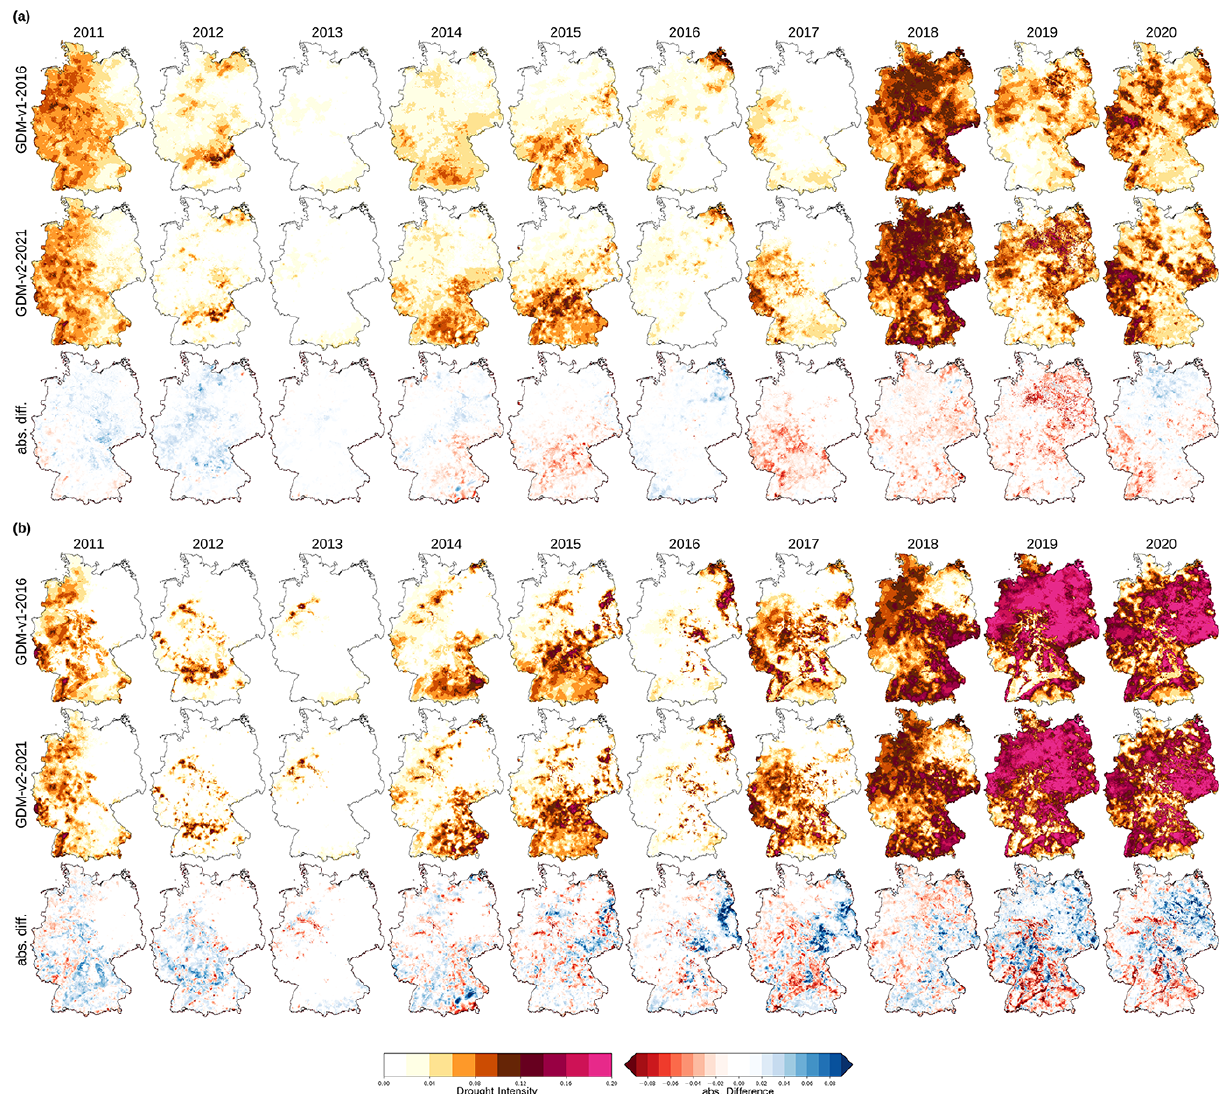
Figure 9. SM drought intensities (DI) per grid cell for (a) upper soil (5–25cm) and (b) total soil column (up to 2m) during the vegetative active period (April–October) in the last decade (2011–2020) for the model setups GDM-v1-2016 and GDM-v2-2021 and for the absolute differences between the setups (GDM-v1-2016 − GDM-v2-2021). The GDM-v1-2016 data were remapped to the GDM-v2-2021 grid for the difference calculation. Graphs, including of years from 1952 onwards, can be found at https://www.ufz.de/index.php?de=47252 (last access: 5 October